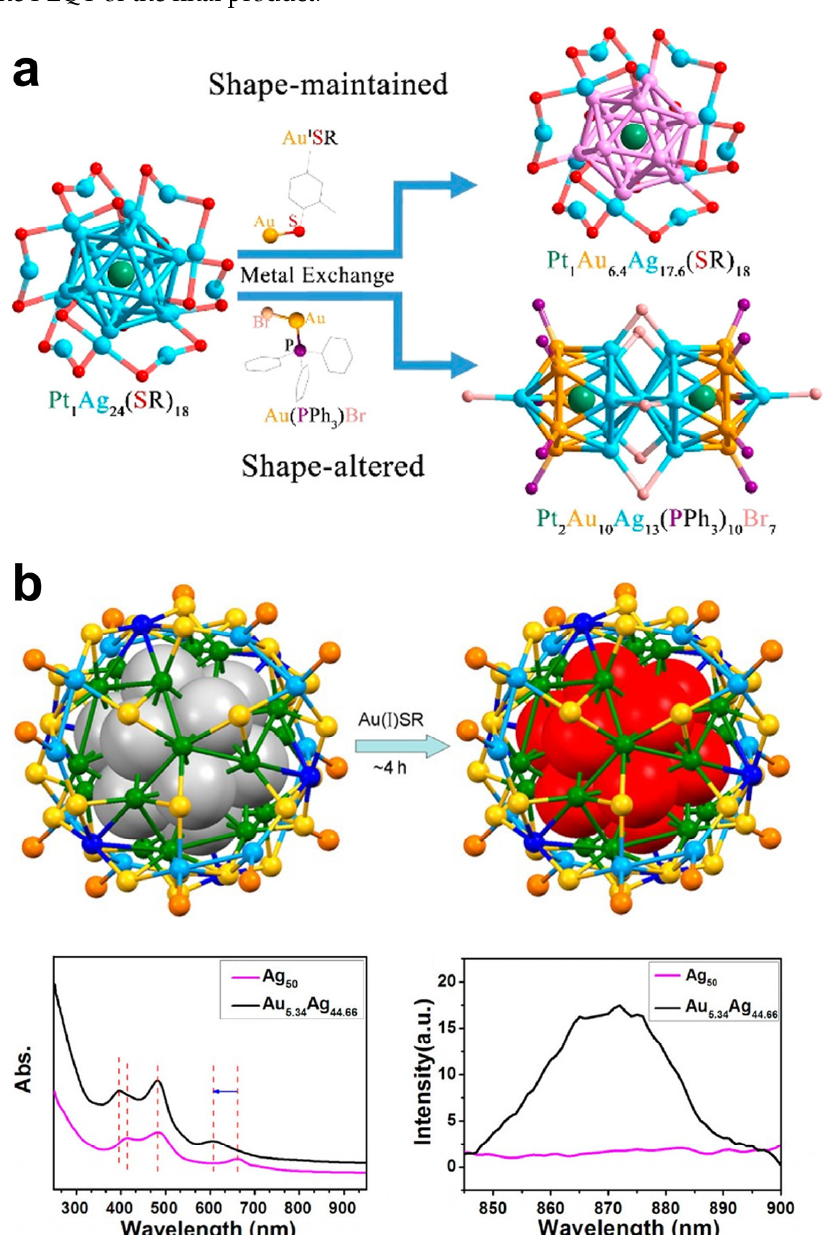
Figure 3. Metal doping-related photoemission of MNCs. ( a ) Shape-controlled synthesis of the sphere and rodlike PtAuAg trimetallic nanoclusters by the metal exchange method. Copyright (2016) Wiley-VCH. ( b ) The upper section is the schematic diagram of the exchange from Ag 50 (Dppm) 6 (TBBM) 30 to Au x Ag 50 − x (Dppm) 6 (TBBM) 30 by Au atom doping. The bottom section is a comparison of the UV − vis and PL spectra of Ag 50 (Dppm) 6 (SR) 30 and Au 5 . 34 Ag 44 . 66 (Dppm) 6 (SR) 30 . Copyright (2017) American Chemical Society.